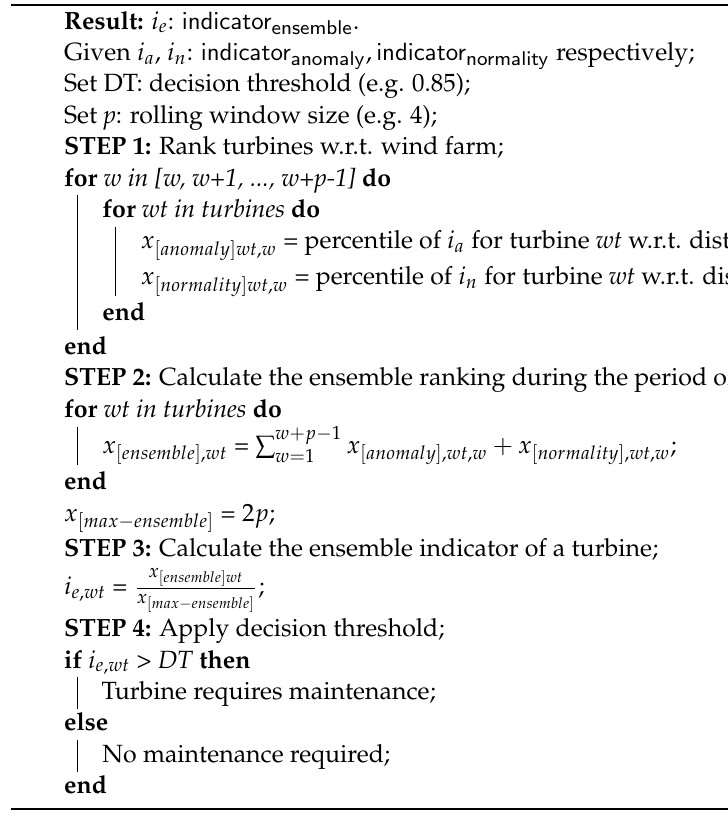
Algorithm 1: Computation of the ensemble indicator